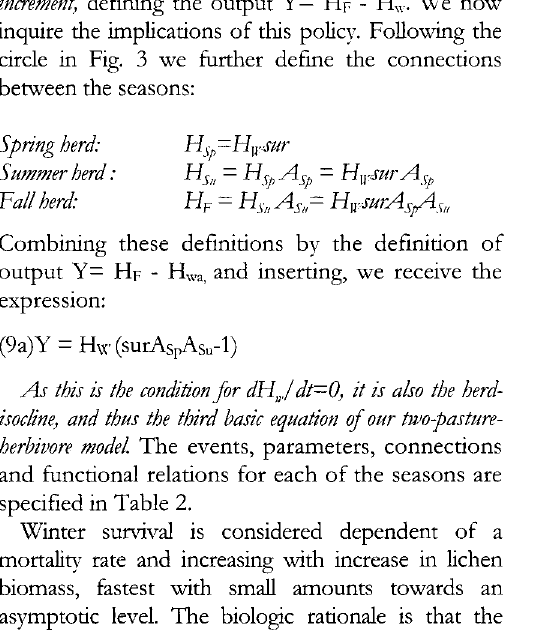
An annual cycle of herd dynamics. Inspired by Virtala (1992:236).